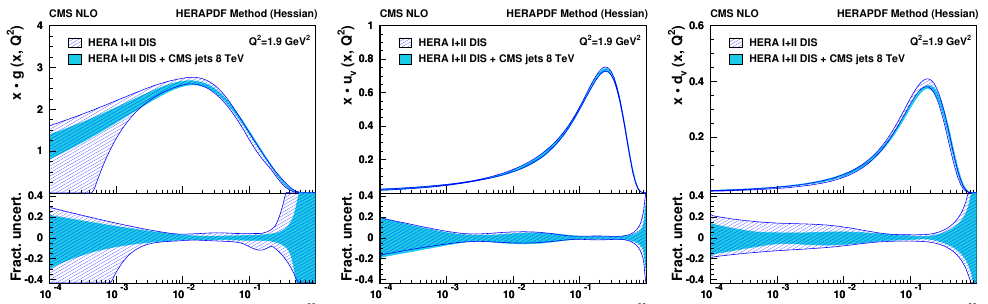
Figure 14 . Gluon (left), u-valence quark (middle), and d-valence quark (right) distributions as functions of x at the starting scale Q 2 = 1 : 9 GeV 2 . The results of the (cid:12)t to the HERA data and inclusive jet measurements at 8 TeV (shaded band), and to HERA data only (hatched band) are compared with their total uncertainties as determined by using the HERAPDF method. In the bottom panels the fractional uncertainties are shown.